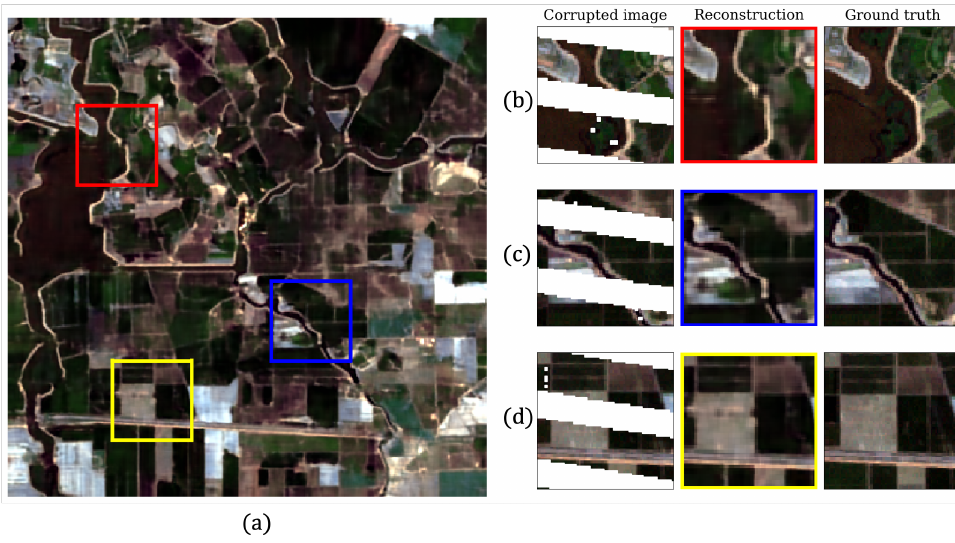
Figure 3. Comparison of DIP reconstruction (55% hidden pixels), image with gap mask and original image for three regions. ( a ) Result of reconstruction. ( b – d ) Parts of image overlapped with gap mask (corrupted image), corresponding parts of reconstructed image and parts of initial image (ground truth),